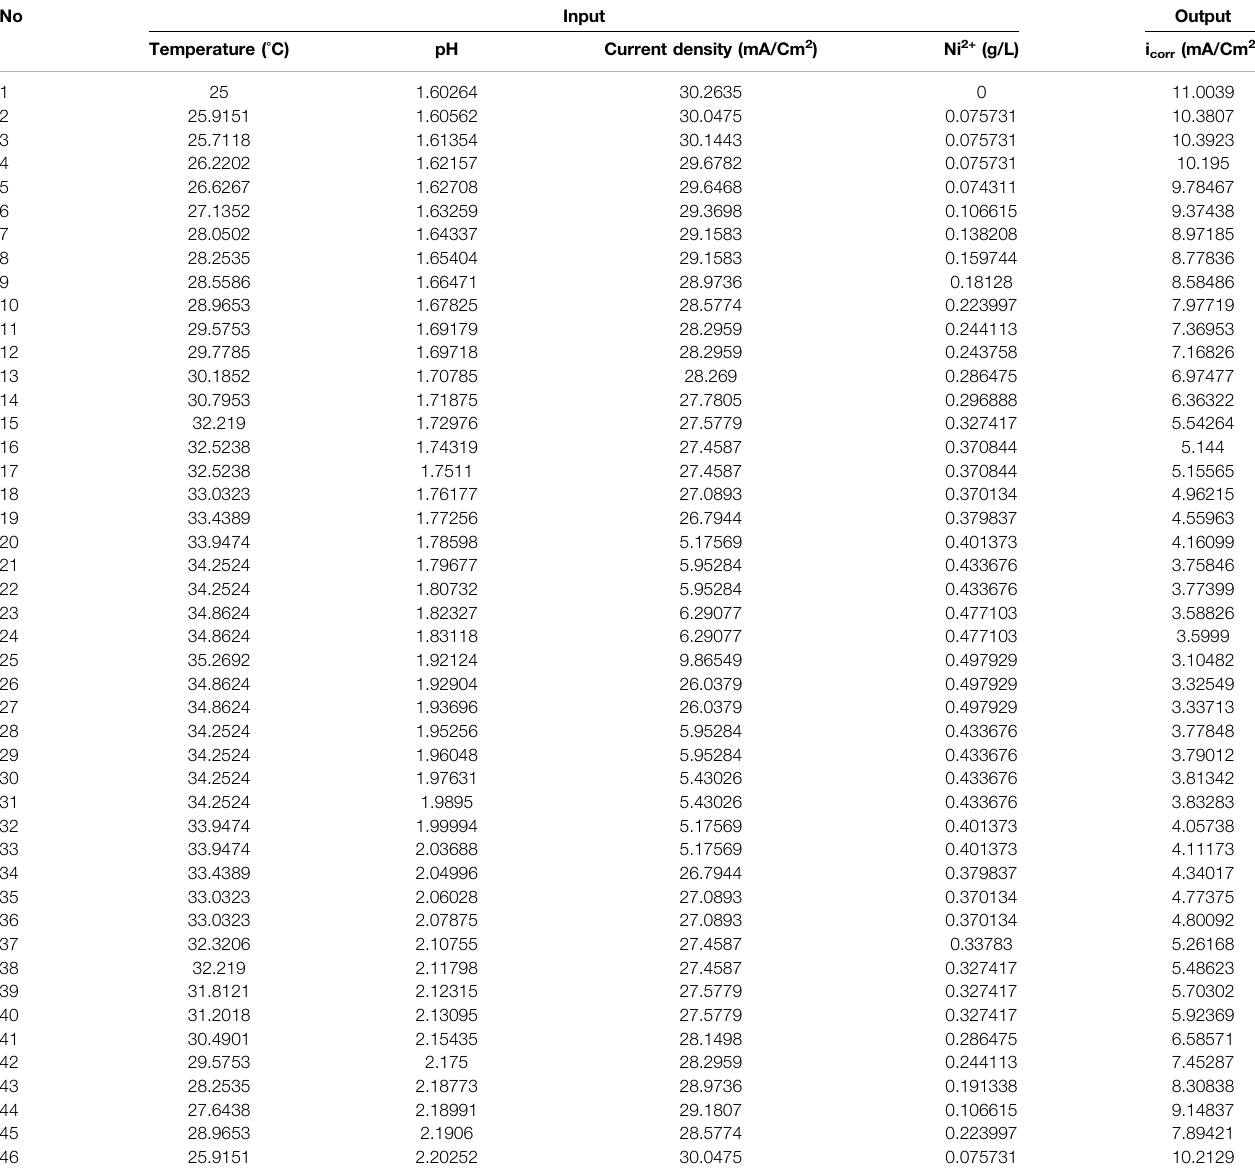
TABLE 2 | Experimental data descriptions for GEP models (Darband et al., 2016a; Darband et al., 2016b).